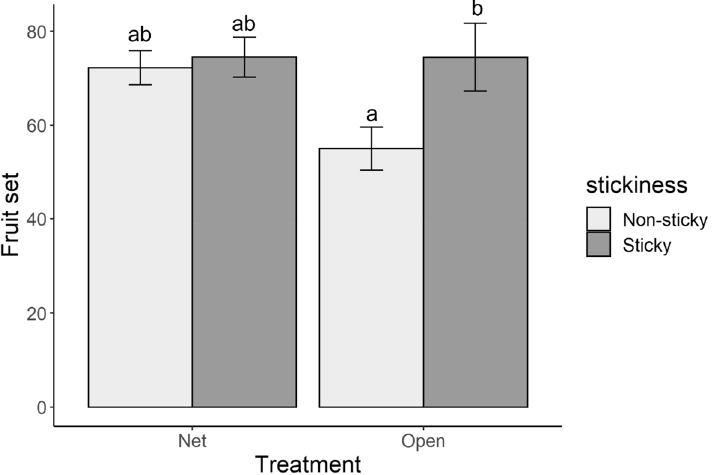
Figure 6. Mean fruit set (± SE) of sticky and non-sticky inflorescences of Bejaria resinosa . Some inflorescences were covered by a net that allow bees and bumblebees to visit the flower but exclude hummingbirds and flower pierces, while others remain open to any flower visitor. Different letters indicate significant differences (Tukey test, significance P = 0.05).